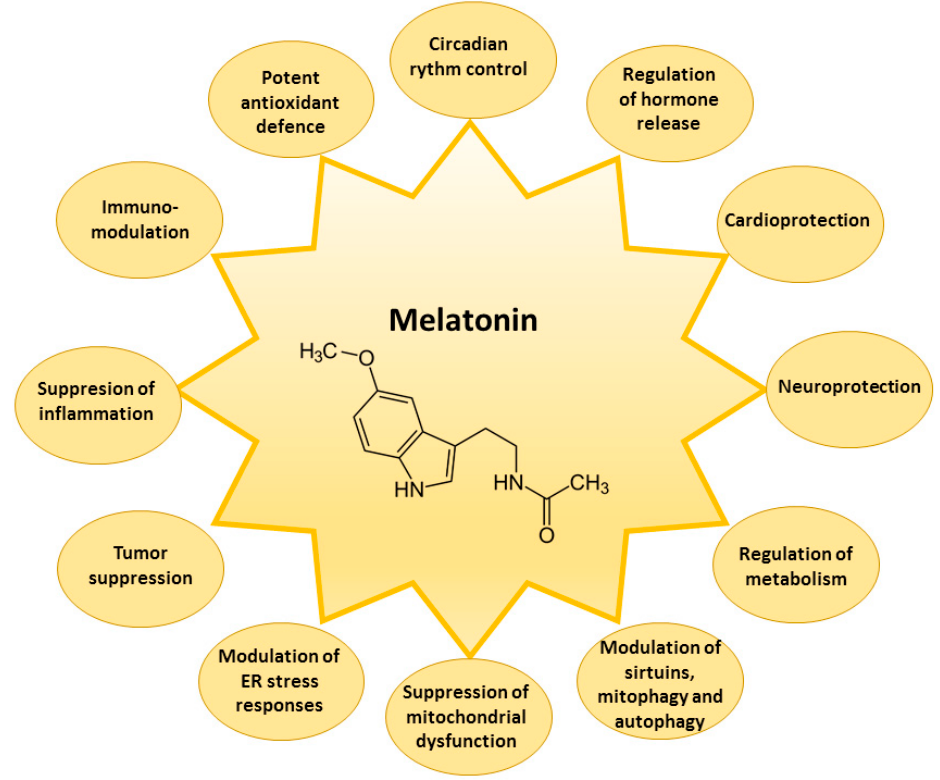
Figure 3. Main biological effects of melatonin in the cell. ER—endoplasmic reticulum.